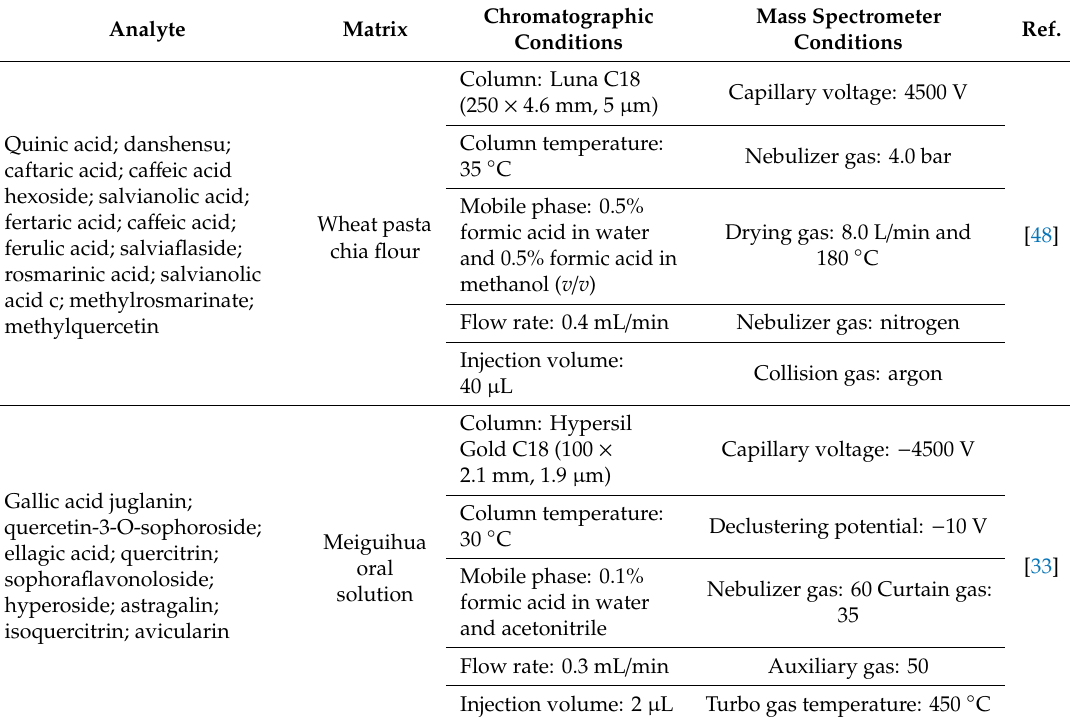
Table 2. Chromatographic and mass spectrometer conditions used in polyphenol